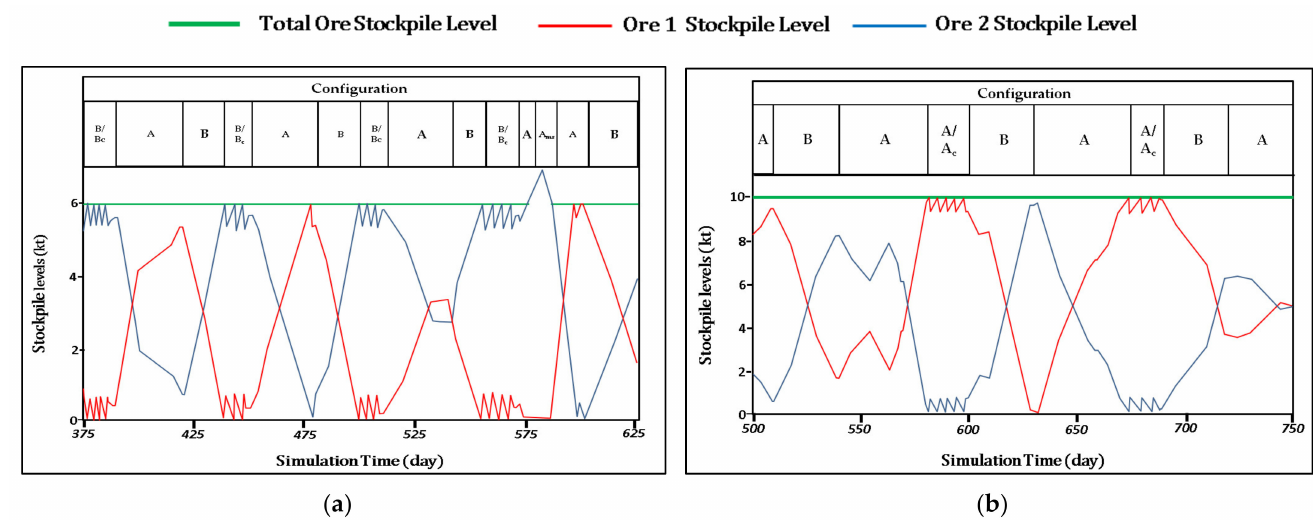
Figure 11. ( a ) System entering into A-Contingency and B-Contingency modes in cyclic time intervals due to the repeating shortages of HCC and LCC ores affecting the operational stability of the plant and the final KPI results. ( b ) Stockpile evolution during simulations with control parameters set at 10,000 t for the Target Ore Stockpile Level (TOSL) and 2000 t for the Critical LCC Stockpile Level, which shows some stockpile shortages and long timeframes without